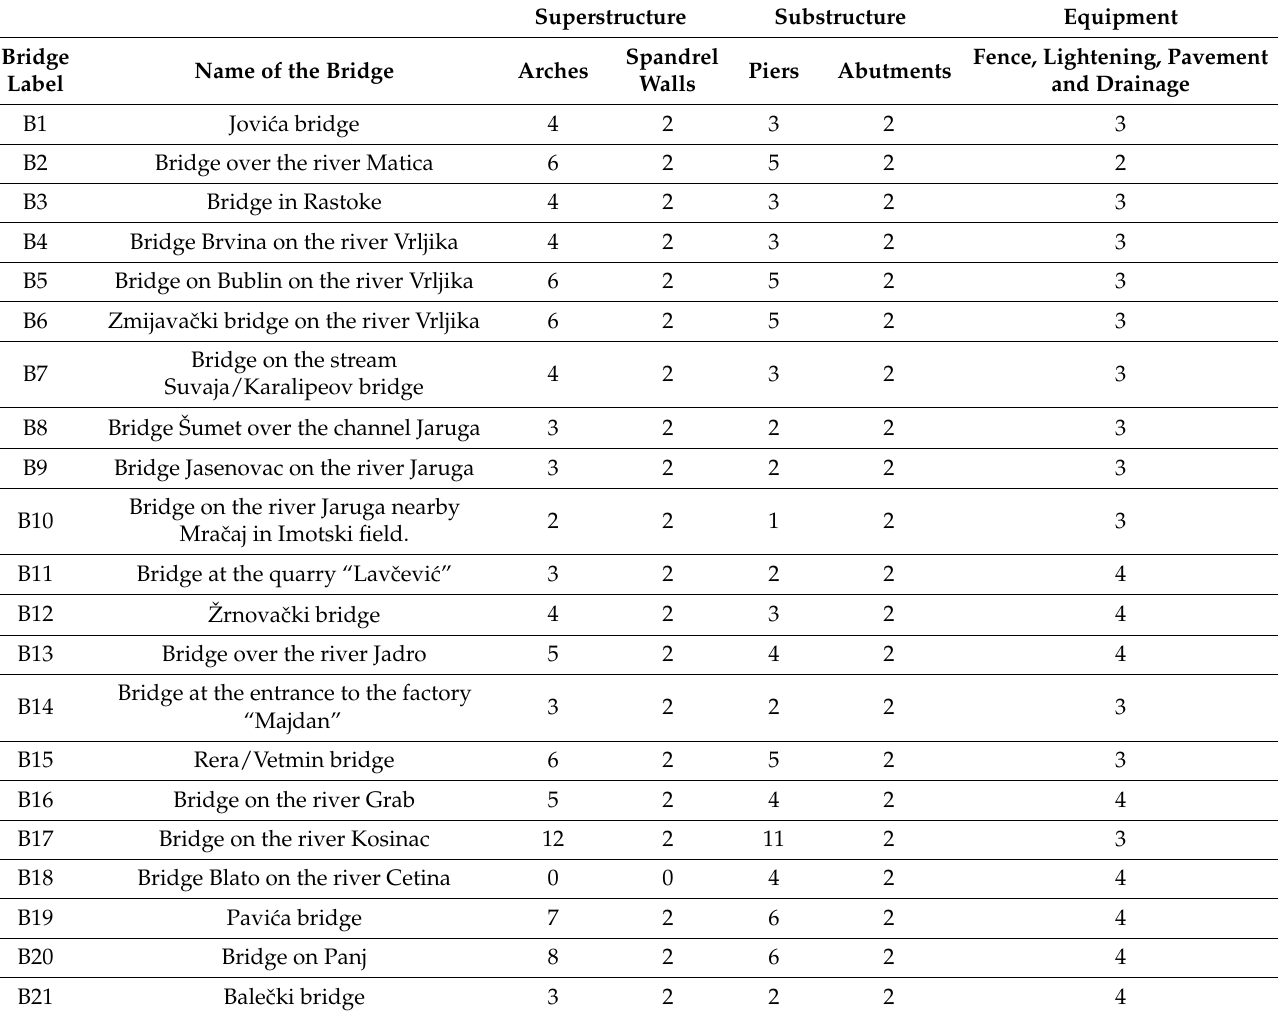
Table 1. Historic road bridges with a total number of elements per component.